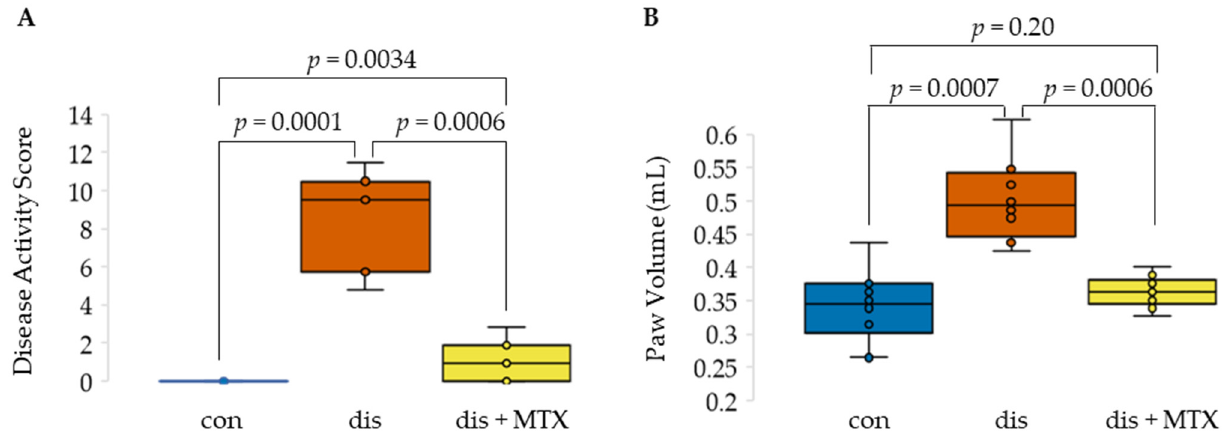
Figure 1. Effects of MTX on disease activity in the CIA mouse model. Box and whisker plots displaying ( A ) disease activity scores and ( B ) paw volumes comparing healthy control mice (con; n = 10), CIA induced disease mice (dis; n = 8), and CIA mice treated with MTX (dis + MTX; n = 9).